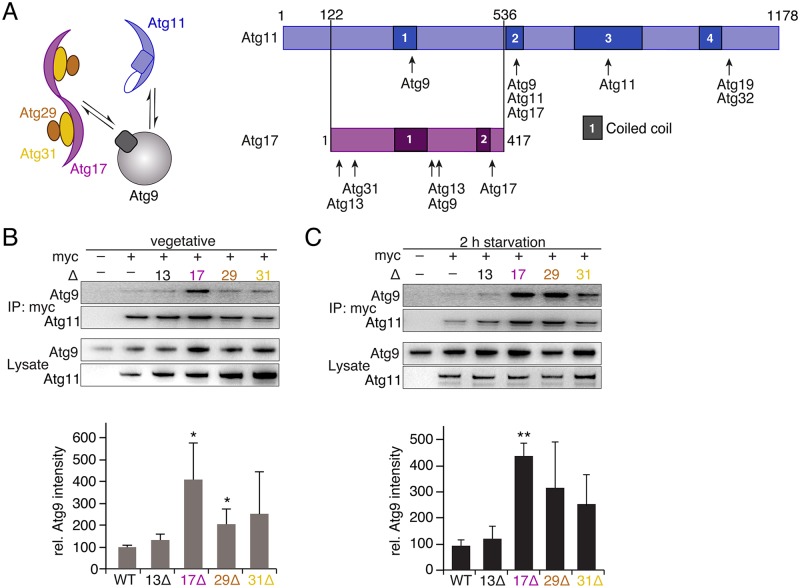
Homologous scaffolds Atg11 and Atg17 compete for binding to Atg9.(A) Schematic drawing illustrates the addressed question. Predicted CC regions of Atg11 and Atg17, and interaction sites with other Atg proteins are indicated. Sequence alignment by ClustalW suggests that Atg17 is homologous to Atg11122-536. (B) IP of myc-tagged Atg11 and co-IP of HA-tagged Atg9 from lysates of WT (−), atg13Δ, atg17Δ, atg29Δ, and atg31Δ cells (log phase). Lysate of nontagged atg11 served as control. Atg11 and Atg9 were detected by α-myc and α-HA immunoblots, respectively. The chart shows corresponding quantifications of Atg9 intensities normalized to the WT and corrected for the total amount of Atg11. (C) IP of myc-tagged Atg11 and co-IP of HA-tagged Atg9 as in (B) but from lysates of starved cells. (B and C) Data are presented as mean values ± SD of n = 3 independent experiments. P values were calculated using a two-tailed Student t test (*P < 0.05, **P < 0.01, ***P < 0.001). Uncropped original blots are shown in S5 Fig. CC, coiled–coil; HA, hemagglutinin; IP, immunoprecipitation; WT, wild-type.